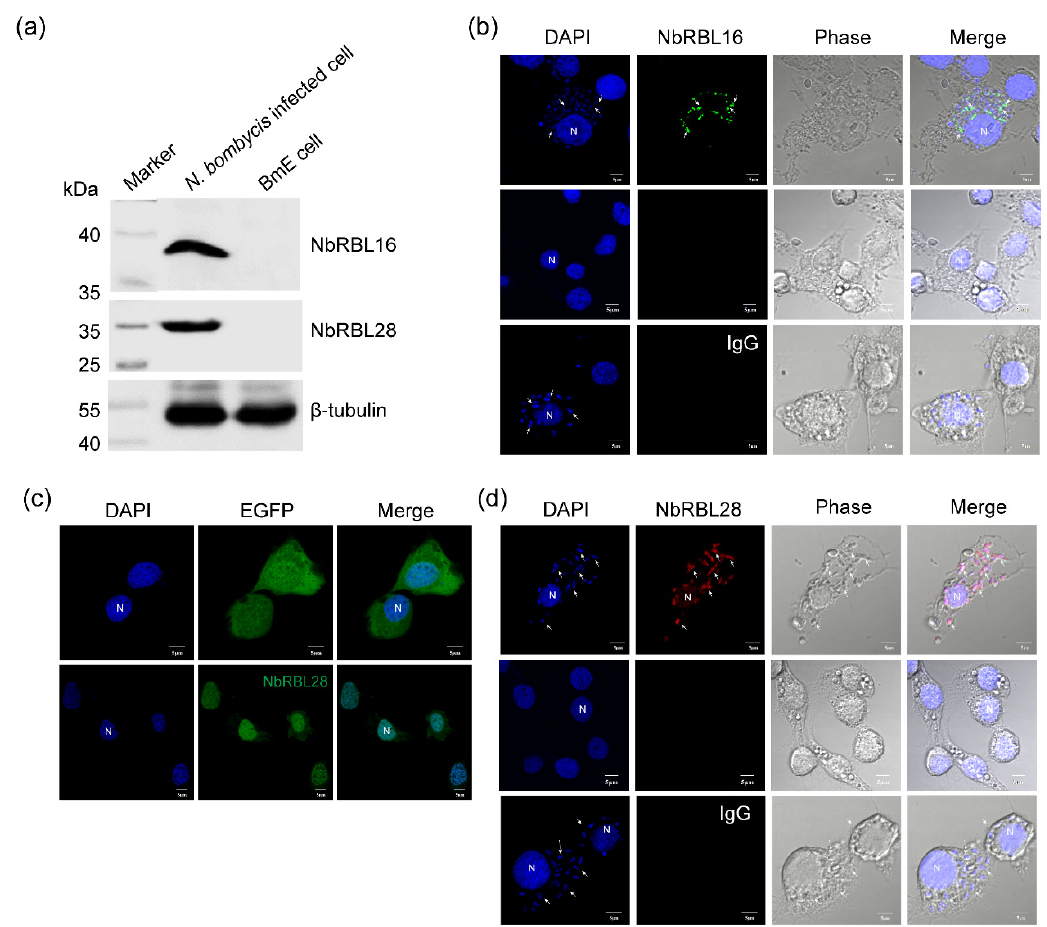
Figure 7. Immunoblot and IFA detecting the subcellular localization of NbRBL16 and NbRBL28 in an infected cell. ( a ) Specific detection of the NbRBL16 and NbRBL28 antibody. Proteins extracted from N. bombycis -infected cells were subjected to Western blot using polyclonal antibody against NbRBL16 and NbRBL28. ( b ) BmE-SWU1 cells were infected with N. bombycis at 48 h. Cells were fixed and stained with DAPI (DNA-specific dye, blue), anti-NbRBL16 (green) antibodies, and the mouse IgG as control. The uninfected BmE-SWU1 cells were incubated with anti-NbRBL16 (green) antibodies as the control. ( c ) The subcellular localization of NbRBL28::EGFP in BmE-SWU1 cell. ( d ) BmE-SWU1 cells were infected with N. bombycis at 48 h. Cells were fixed and stained with DAPI DNA-specific dye (blue), anti- NbRBL28 (red) antibodies and the mouse IgG as control. The uninfected BmE-SWU1 cells were incubated with anti-NbRBL28 (red) antibodies as control. The white arrowheads indicate N. bombycis . Bars, 5 μ m.